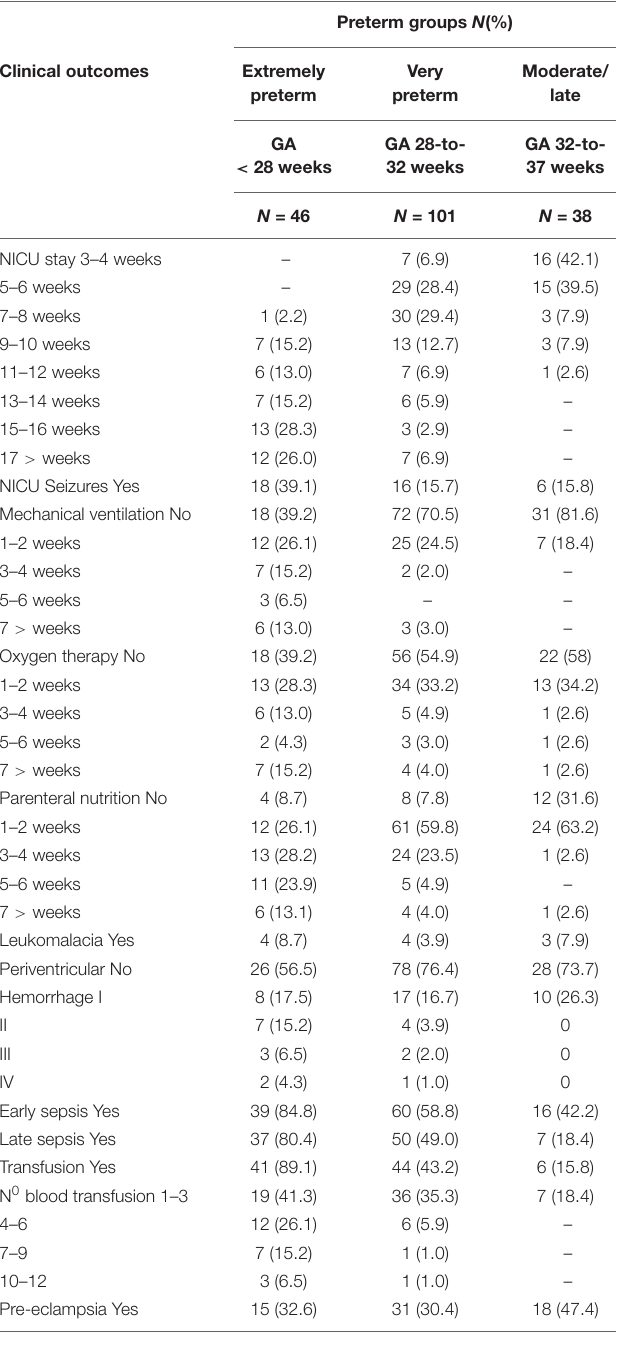
TABLE 1 | Sample demographic by